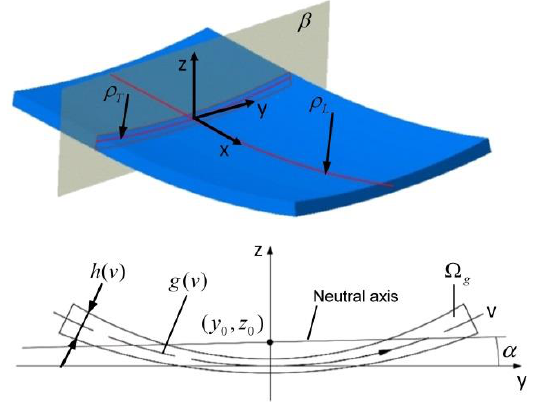
Figure 3. Illustration of the roll gap.